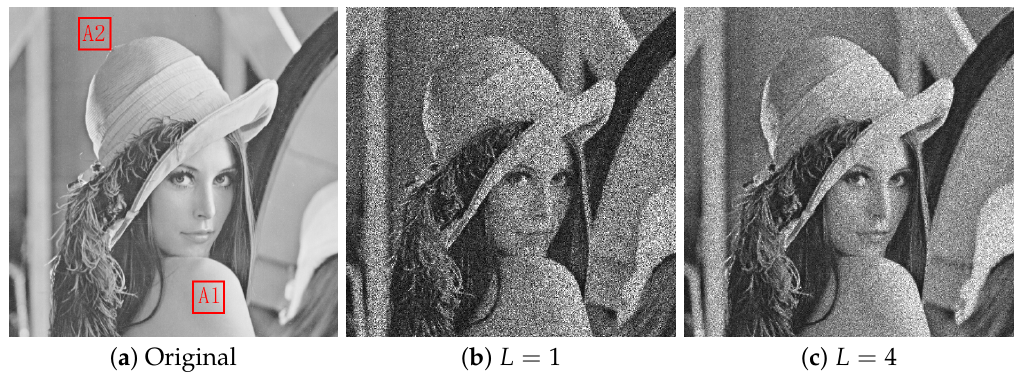
Figure 5. The simulated SAR images with different L : ( a ) original; ( b ) L = 1; and ( c ) L =